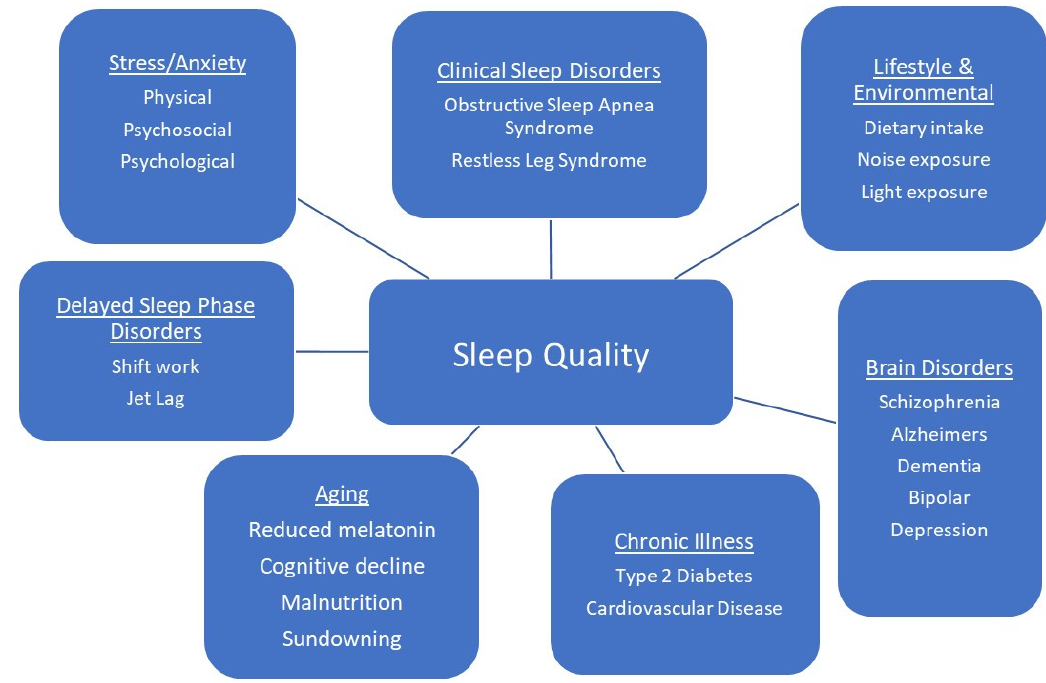
Figure 1. Factors Affecting Sleep Quality.